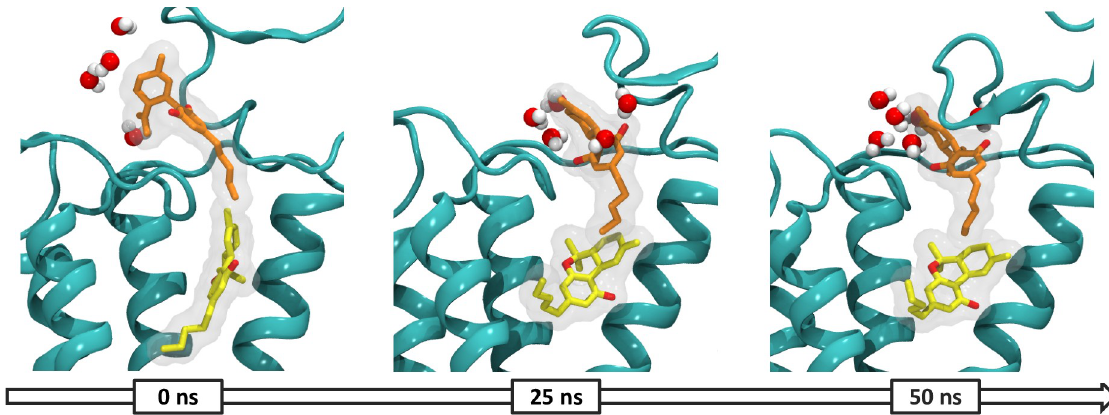
Fig 7. Solvent rearrangement around CBD in the agonist bound CB 1 R. CBD (orange), THC (yellow) and water molecules within � 3 Å in the active conformation of the CB 1 R at 0, 25 and 50 ns of simulation.